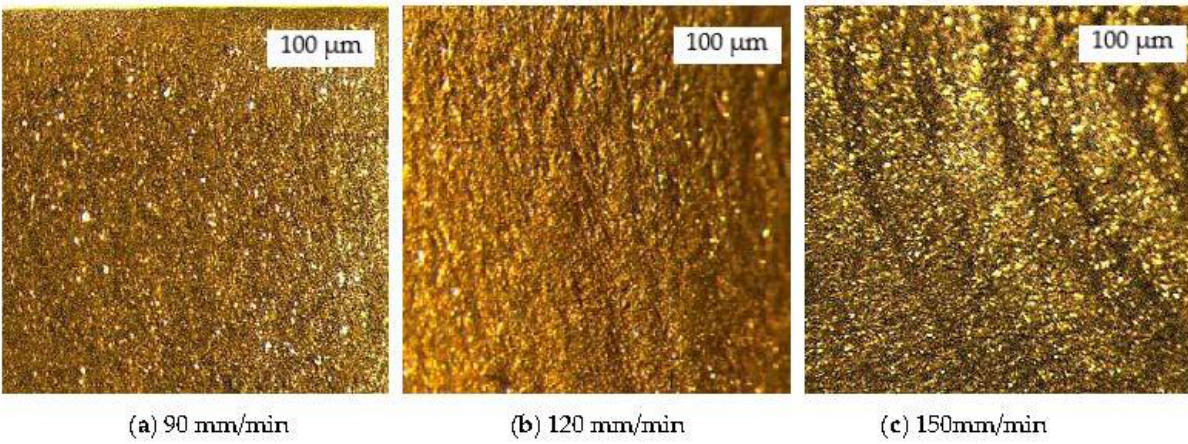
Figure 4. Topography of AISI 304L cut surface with 4 mm thickness using varied traverse speed.